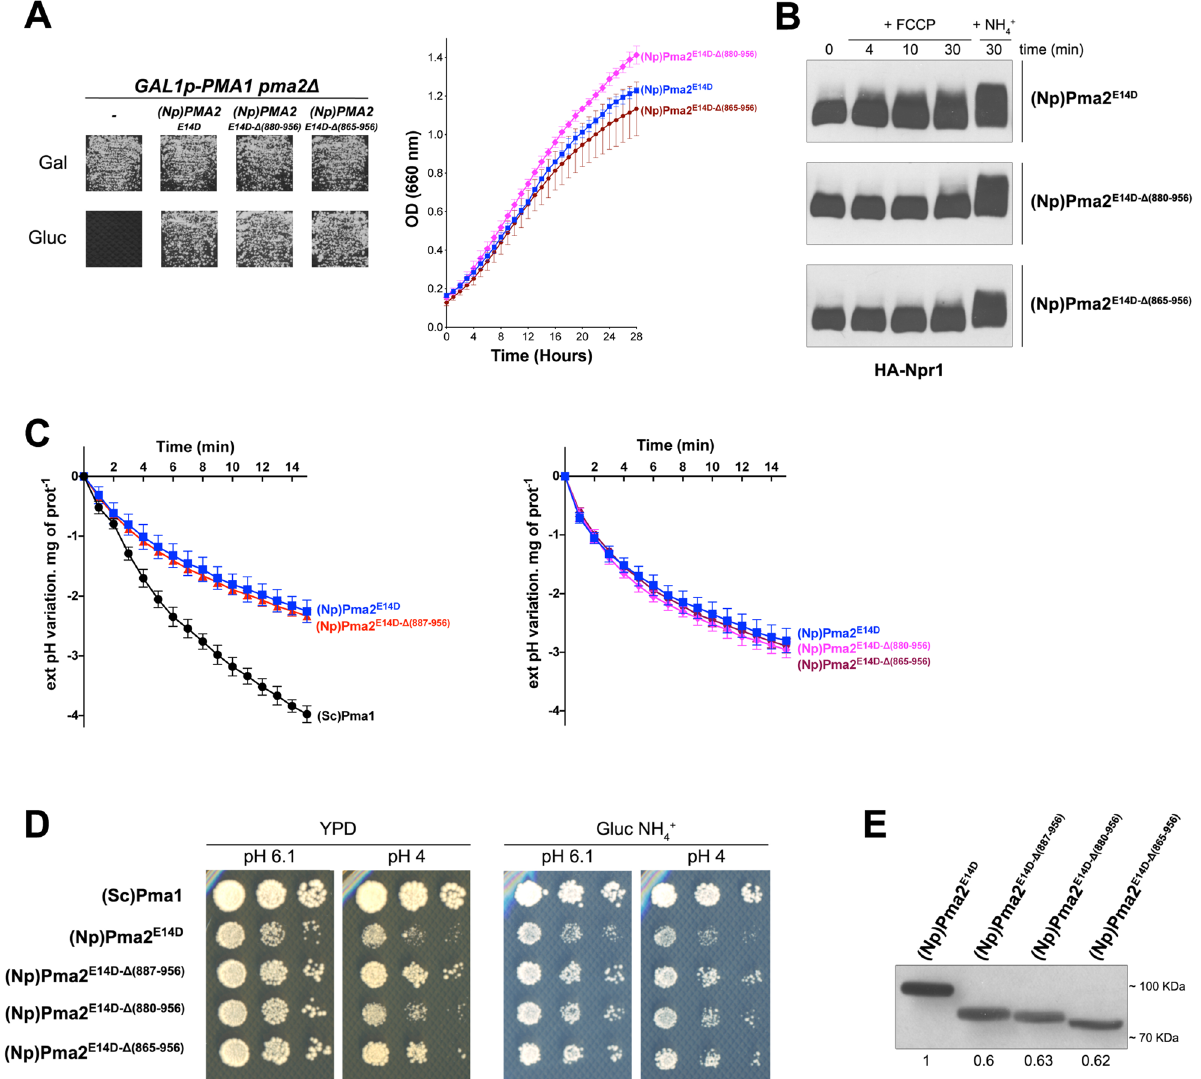
Figure 3. The inability of C-terminally truncated PMA2 forms to activate TORC1 is not associated with reduced H + pumping activity. ( A ) Left. GAL1p-PMA1 pma2Δ cells expressing, from a plasmid, either (Np) PMA2 E14D , (Np)PMA2 E14D-Δ(880-956) , (Np)PMA2 E14D-Δ(865-956) , or no H + -ATPase (-) were grown for 3 days on solid medium with NH 4 + as sole nitrogen source and Gal or Gluc as carbon source. Right. GAL1p-PMA1 pma2Δ cells expressing, from plasmids, either (Np)PMA2 E14D , (Np)PMA2 E14D-Δ(880-956) , or (Np)PMA2 E14D-Δ(865-956) along with HA-NPR1 were grown on Gluc NH 4+ medium in a microplate reader for 28 h. Data points represent averages of the OD at 660 nm of two biological replicates; error bars represent SD. ( B ) The same cells as in panel A (right) were grown on Gluc NH 4+ medium. After a shift to Gluc proline medium for four hours, culture samples were collected before and 4, 10, and 30 min after addition of FCCP (20 µM) or 30 min after addition of NH 4+ (5 mM). Crude extracts were prepared and immunoblotted with the anti-HA antibody. The signals are from the same gel and exposure times were identical. Strains are presented in separate panels for convenience. ( C ) Left. GAL1p-PMA1 pma2Δ cells expressing, from plasmids, either (Sc)Pma1 , (Np)PMA2 E14D , or (Np) PMA2 E14D-Δ(887-956) along with HA-NPR1 were grown on Gluc NH 4+ medium. Acidification by these cells of the external medium was measured as described in Materials and Methods. Right. Same as in the left panel, except that cells expressing (Np)PMA2 E14D , (Np)PMA2 E14D-Δ(880-956) , or (Np)PMA2 E14D-Δ(865-956) were analyzed. Average values of three biological replicates are shown, and error bars correspond to SD. ( D ) GAL1p-PMA1 pma2Δ cells expressing, from plasmids, either (Sc)Pma1, (Np)PMA2 E14D , (Np)PMA2 E14D-Δ(887-956) , (Np)PMA2 E14D-Δ(880-956) , or (Np)PMA2 E14D-Δ(865-956) along with HA-NPR1 were spotted in two-fold serial dilutions on solid rich (YPD) or Gluc NH 4+ (pH 6.1 or 4) medium and incubated for four days. ( E ) GAL1p-PMA1 pma2Δ cells expressing, from plasmids, either (Np)PMA2 E14D , (Np)PMA2 E14D-Δ(887-956) , (Np)PMA2 E14D-Δ(880-956) or (Np)PMA2 E14D-Δ(865-956) along with HA-NPR1 were grown on Gluc NH 4+ medium. After a shift to Gluc proline medium for four hours, the cells were collected. Crude extracts were prepared and immunoblotted with the anti-polyHis antibody. Direct Blue 71 staining (Sigma-Aldrich) was used for quantitative comparisons and signals were normalized to the signal of (Np)PMA2 E14D -expressing cells. Original blots of figure panels B and E are presented in Fig.